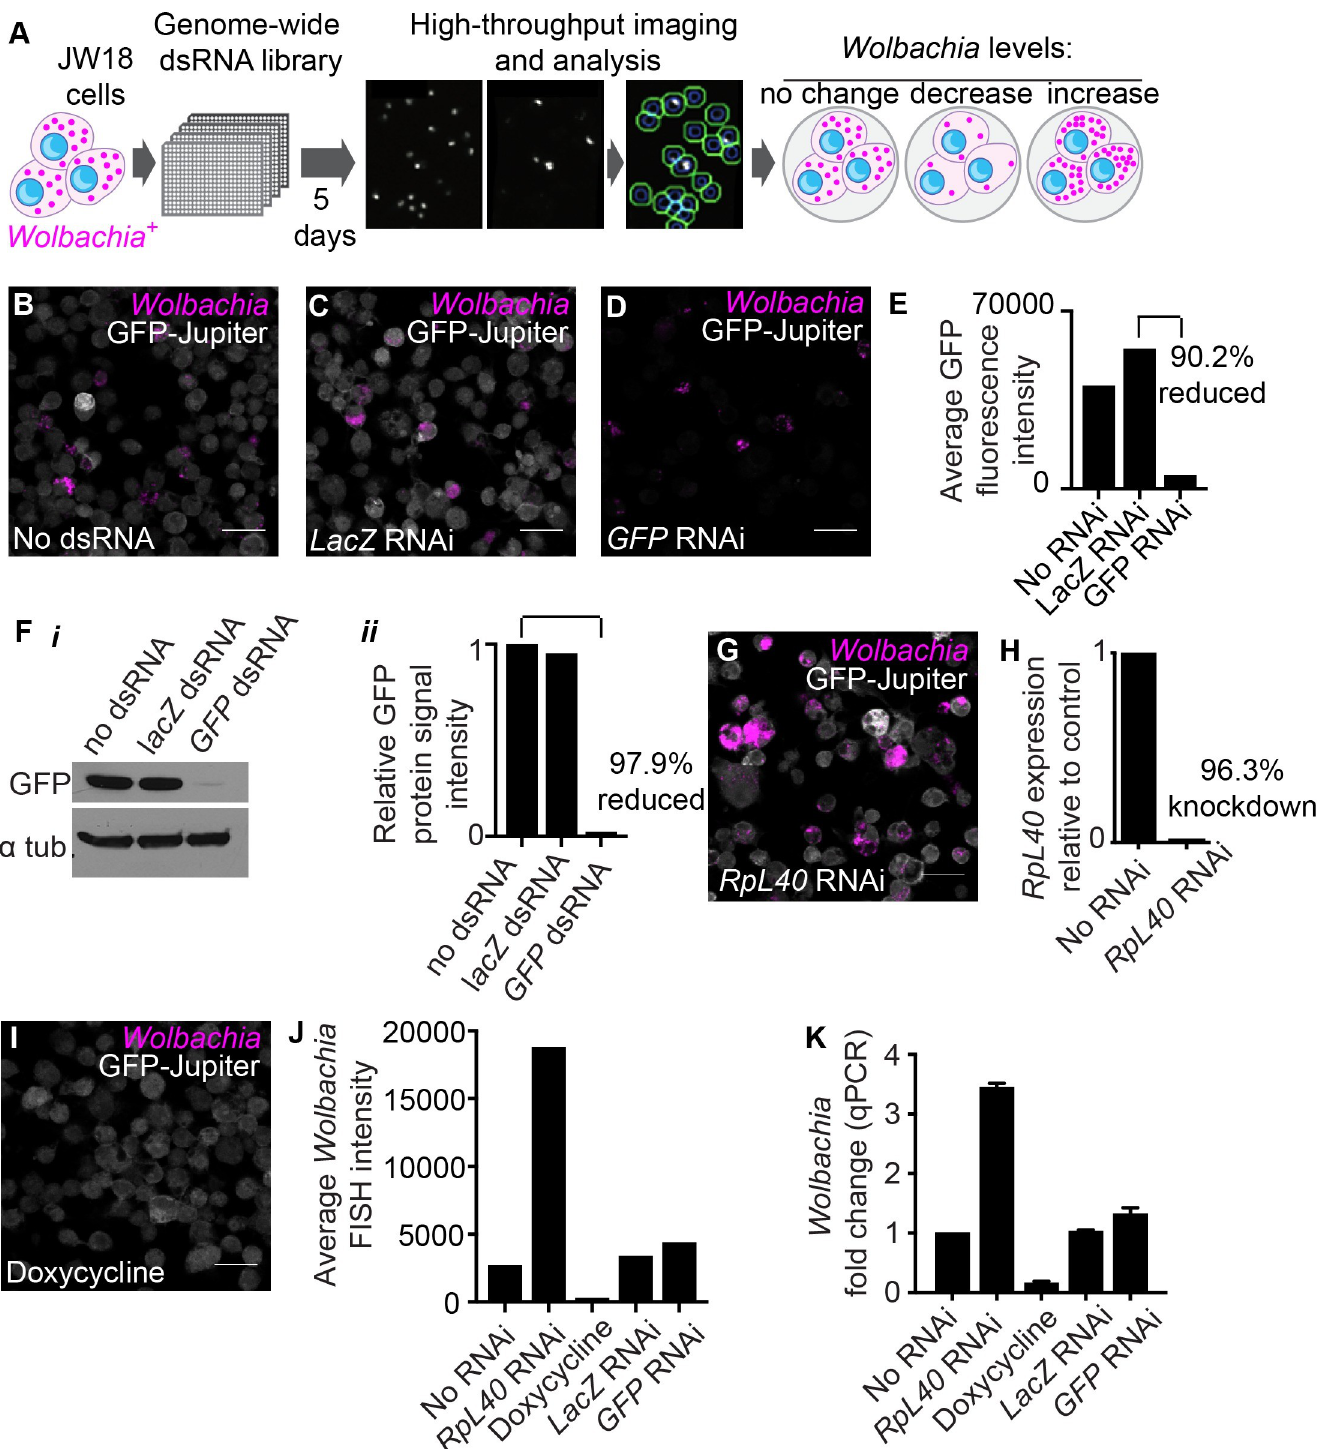
Fig 2. Genome-wide screening approach to find novel Wolbachia -host interactions in Wolbachia -infected JW18 Drosophila cells. (A) Schematic of screen layout. Wolbachia -infected JW18 cells are seeded into 384-well plates pre-arrayed with the DRSC version 2.0 whole genome RNAi library designed to include dsRNAs that target the whole Drosophila genome. All plates were screened in triplicate. Cells and dsRNA were incubated for 5 days before processing for an automated high- throughput RNA-FISH assay to detect changes in Wolbachia 23s rRNA levels. ( B) Representative image of Wolbachia detection at 20x with the 23s rRNA Wolbachia FISH probe (magenta) in JW18 cells containing a GFP-Jupiter transgene labeling microtubules (grey). ( C) Negative control dsRNA against LacZ not present in our